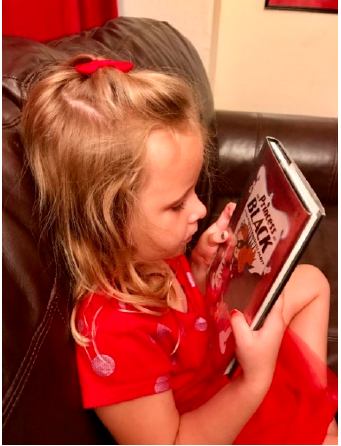
Figure 7. Child, using accommodation.